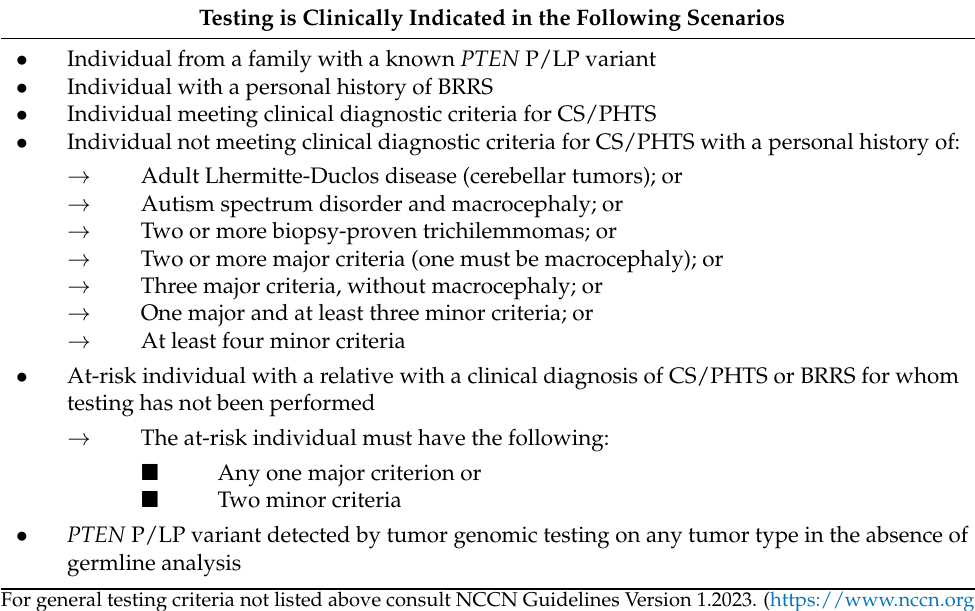
Table 3. Testing criteria for Cowden Syndrome/ PTEN Hamartoma Tumor Syndrome [3]. Testing is Clinically Indicated in the Following Scenarios